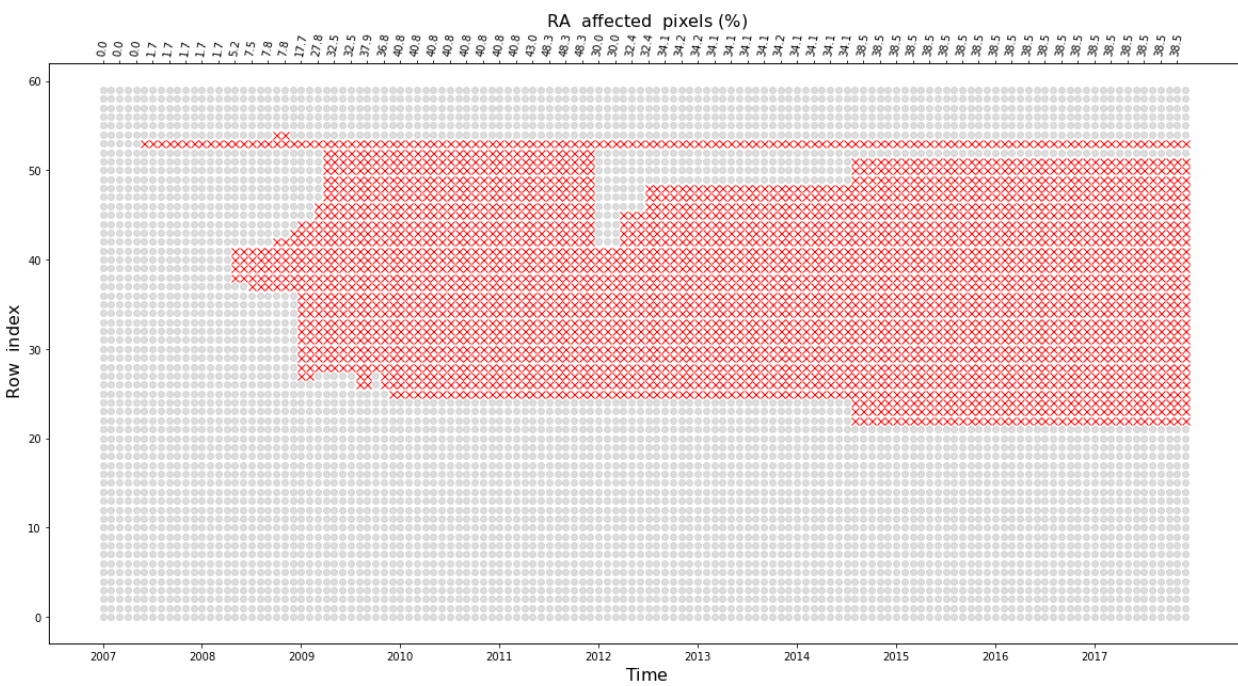
Figure 1. OMI row anomaly in the UV-2/VIS channel as a function of time throughout the OMI mission (2007–2017). Prior to 2007, there was no row anomaly. Affected rows (red crosses) are suffering from a partial blockage of light entering the instrument, so that the absolute radiance levels become compromised. The upper x axis indicates the percentage of OMI pixels (defined as the 100% × ratio of the number of pixels affected by the row anomaly to the total number of pixels) being affected in a particular